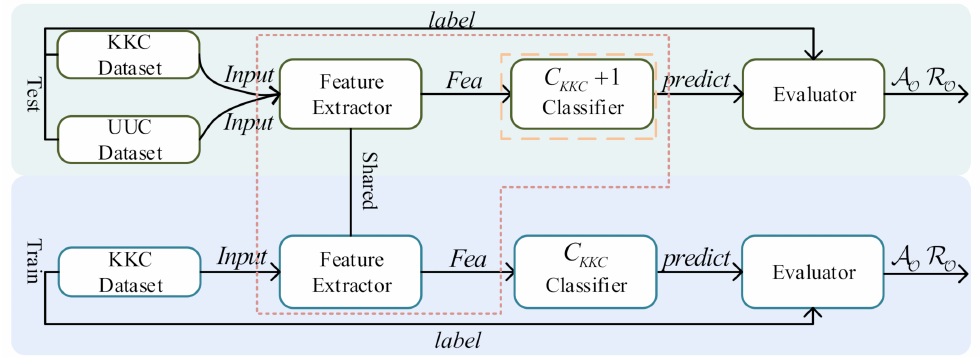
Figure 3. The architecture of current open-set SEI